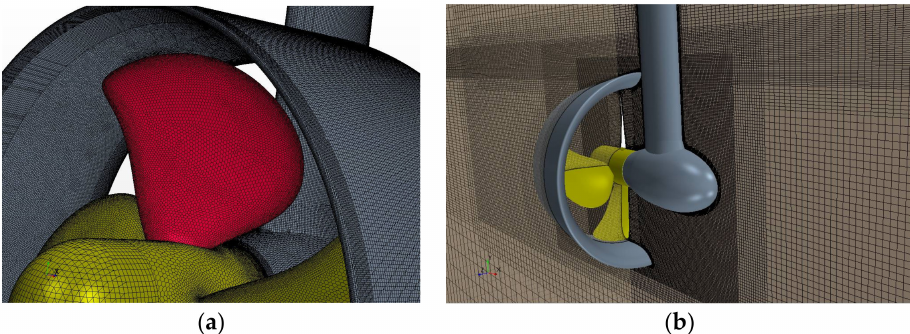
Figure 4. Details of computation mesh: ( a ) surface mesh on propeller and duct; ( b ) volume mesh around propulsor and free